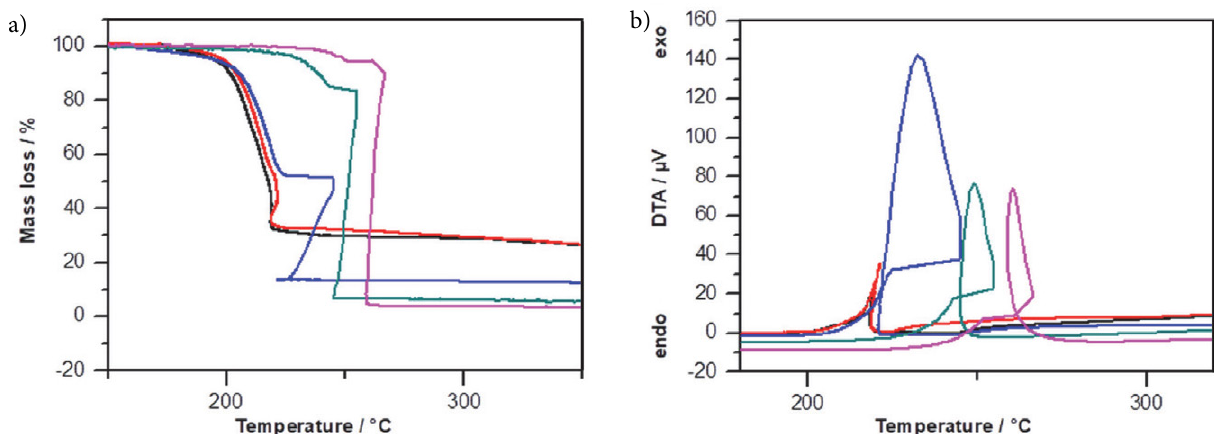
Figure 3. a. Thermogravimetric curves, b. DTA curves of N -(5-chloro-2,4-dinitrophenyl)hydrazine ( 1 ) recorded at different low heating rates [black: 0.6 °C min –1 , red: 0.75 °C min –1 , blue: 1 °C min –1 , darkcyan: 5 °C min –1 , purple: 15 °C min –1 ].